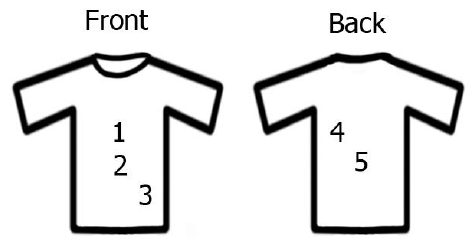
Figure 7. Positions of setup placed on subject study. On the front side: (1) on a heart region; (2) above the navel; (3) above the left hipbone; and on the back side: (4) below left shoulder blade; (5) in the middle of the